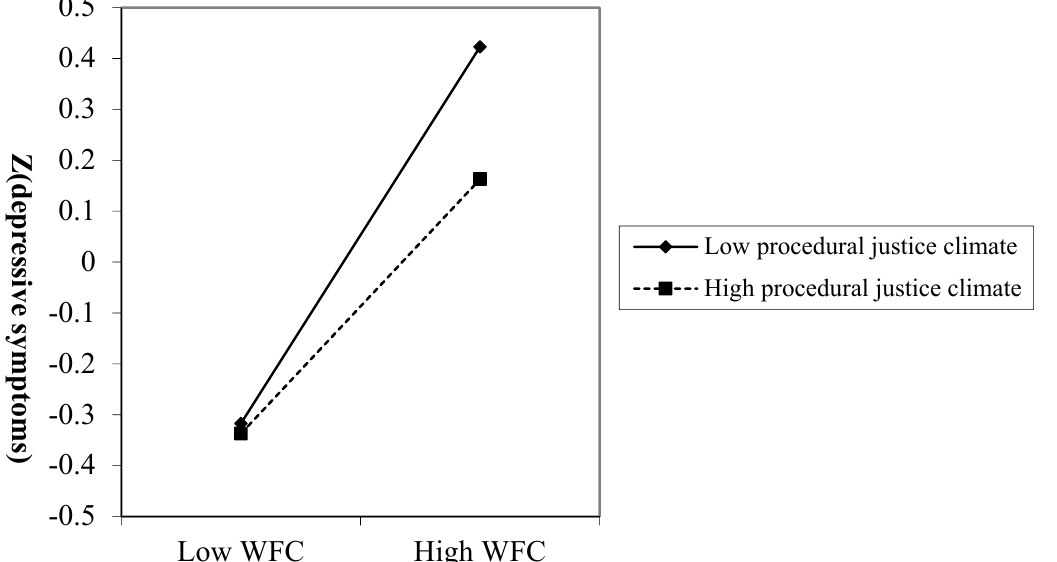
Figure 2. The relationship between work-to-family conflict (WFC) and depressive symptoms was moderated by procedural justice climate. The interaction patterns of WFC × Distributive justice climate, WFC × Interpersonal justice climate, and WFC × Informational justice climate were similar to Figure 2.